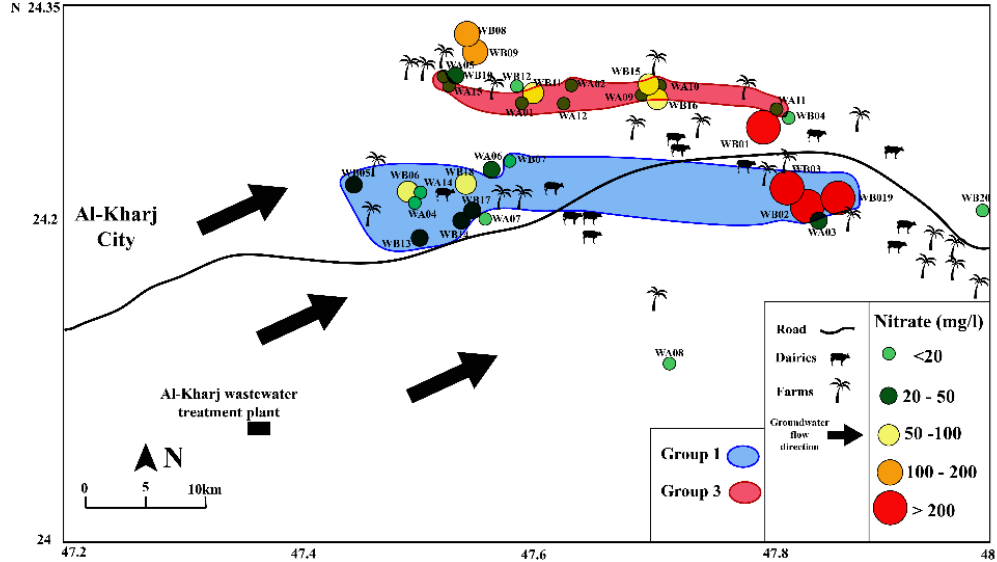
Figure 5. Map of measured nitrate concentrations in the Wasia aquifer and land use in the Al Kharj study area. Also shown is the attribution of water samples to Groups 1 and 3 according to the Piper diagram (Figure 6). All other shown sample sites belong to Group 2.